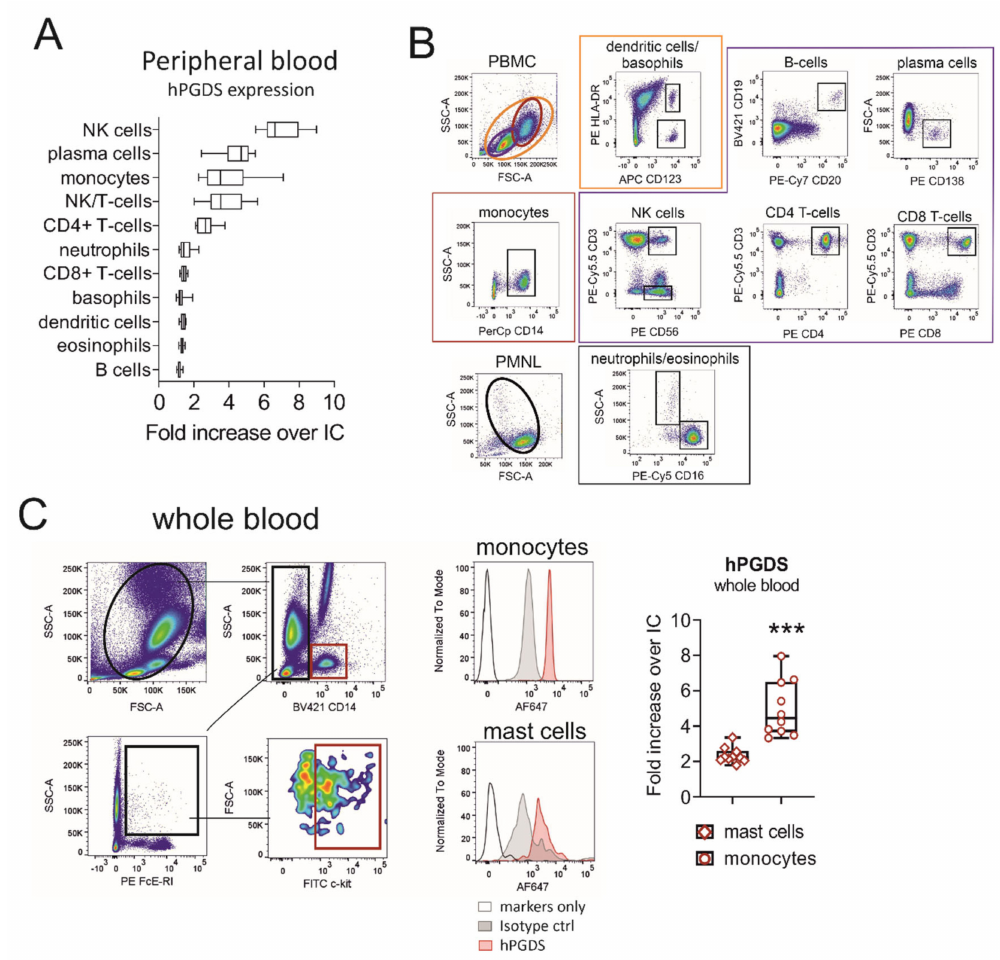
Figure 1. Evaluation of hematopoietic PGD synthase expression in human peripheral blood leukocytes highlights monocytes as a potential PGD 2 source. ( A ) CD14 + monocytes, CD4 + T-cells, NK/T and NK cells as well as plasma cells stained highly positive for hPGDS. ( B ) Gating strategy for peripheral blood leukocytes, which were stained in the PMNL or PBMC fraction of peripheral blood from human donors. ( C ) For comparison, hPGDS expression in circulating mast cells and monocytes was determined in whole blood. Data are shown as box-and-whisker, n = 10, Student’s t-test (*** p <